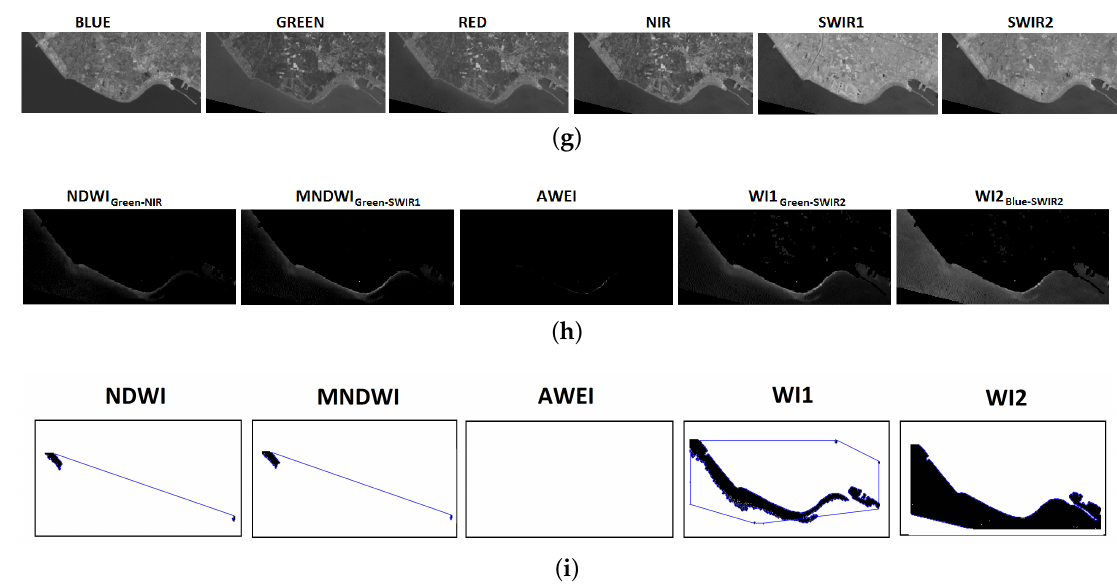
Figure 14. Errors detected after the methodology was applied to the set of 264 images in the Guadalfeo River Delta. ( a ) The corrected Landsat band images from 7 March 1985. ( b ) The water indexes calculated from Landsat band images from 7 March 1985. ( c ) The coastline detected from water indexes calculated from a Landsat Image (7 March 1985). ( d ) The corrected Landsat image from 3 April 2015. ( e ) The water indexes calculated from Landsat band images from 3 April 2015. ( f ) The coastline detected from water indexes calculated from a Landsat Image (3 April 2015). ( g ) The corrected Landsat image from 24 June 2013. ( h ) The water indexes calculated from Landsat band images from 24 June 2013. ( i ) The coastline detected from water indexes calculated from a Landsat Image (24 June 2013).